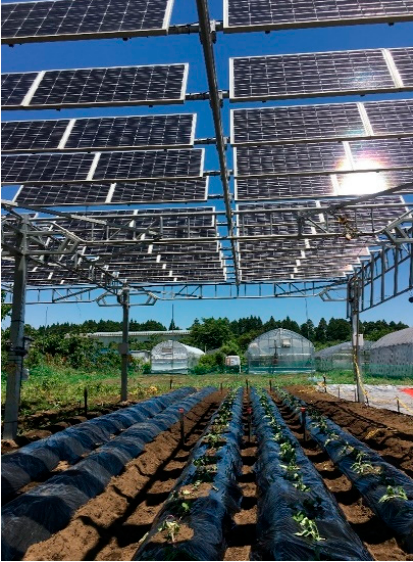
Figure 2. Photo of agrivoltaic system (from Yajima et al. [50]).